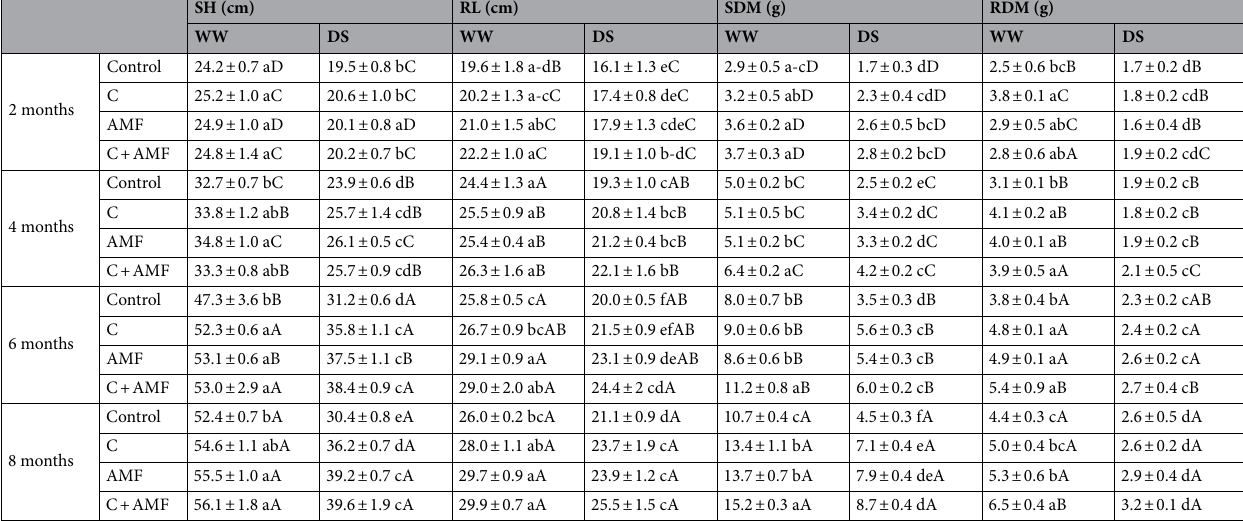
Table 2. Growth parameters (SH: Shoot Height, RL: Root Length, SDM: Shoot Dry Matter, RDM: Root Dry matter) in carob under different water status (WW: well-watered, DS: drought stress) and/or biofertilizers (C: compost, AMF: arbuscular mycorrhizal fungi, C + AMF: compost and AMF consortium combination) after 2, 4, 6, and 8 months of treatments’ application. Means (± standard error) within the same parameter, followed by different letters, are significantly different among treatments at P ≤ 0.05. The upper case represents the differences within WW or DS water regime, and the lower case represents the differences within a one-time